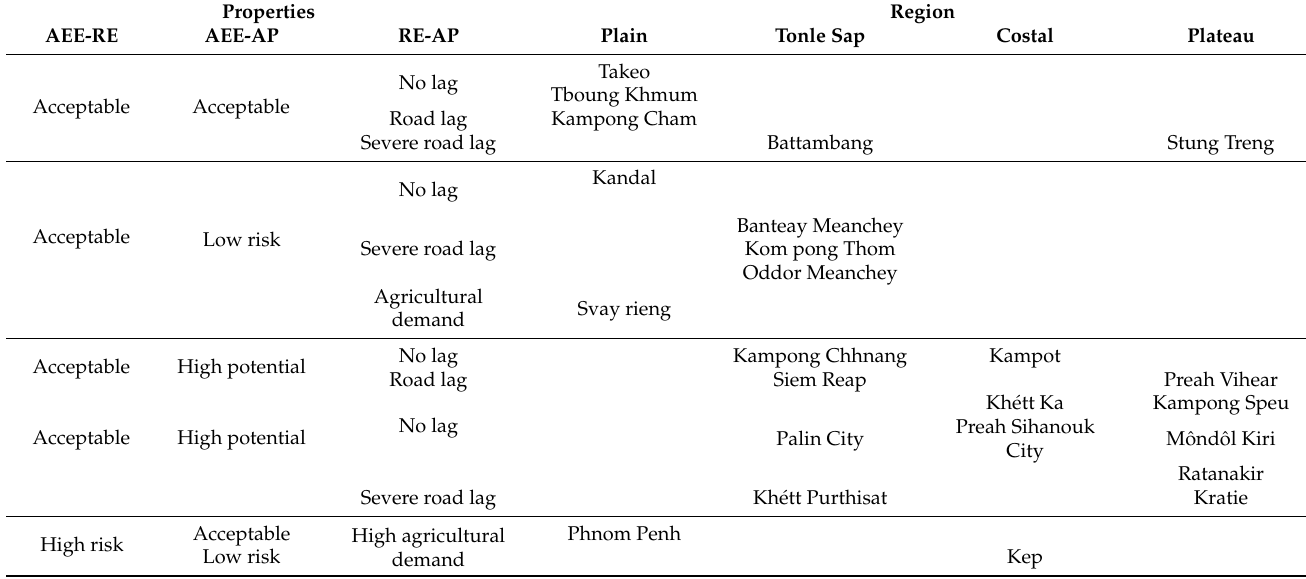
Table 6. Relationship between agriculture, roads, and agricultural eco-environment systems in Cambodia.